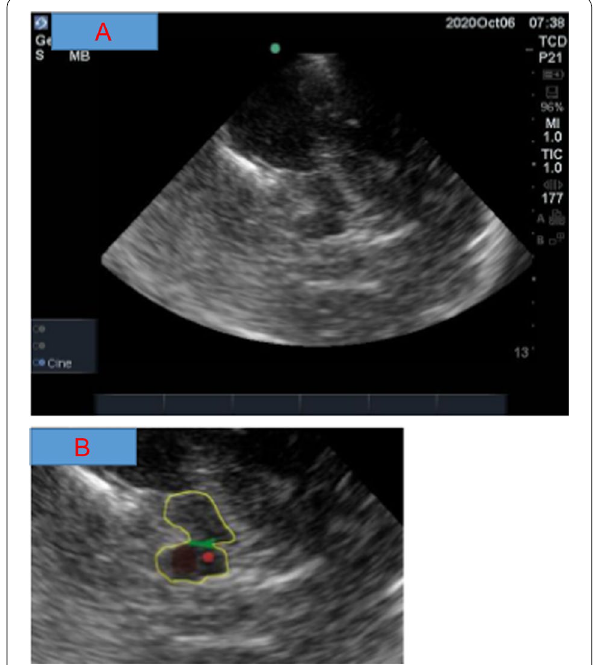
Fig. 1 Mid-brain and visible compartment. A Trans-temporal approach, midbrain plane. B Yellow line indicates the margin of the midbrain, red nucleus in red, Raphe nucleus in green and substantia nigra in brown